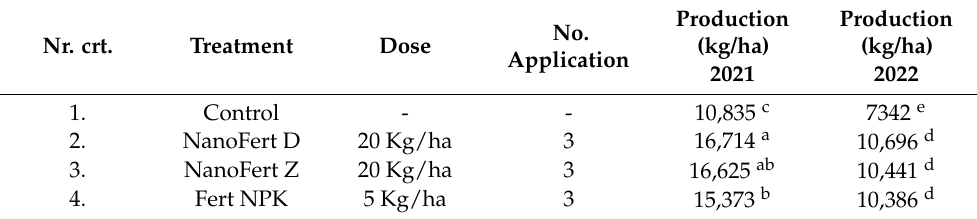
Table 5. Productive efficiency (kg/ha) after foliar fertilization with fertilizers and fertilizers combined with film-forming material applied to apple (Idared variety) in an intensive, non-irrigated orchard compared to the control—2021 and 2022.